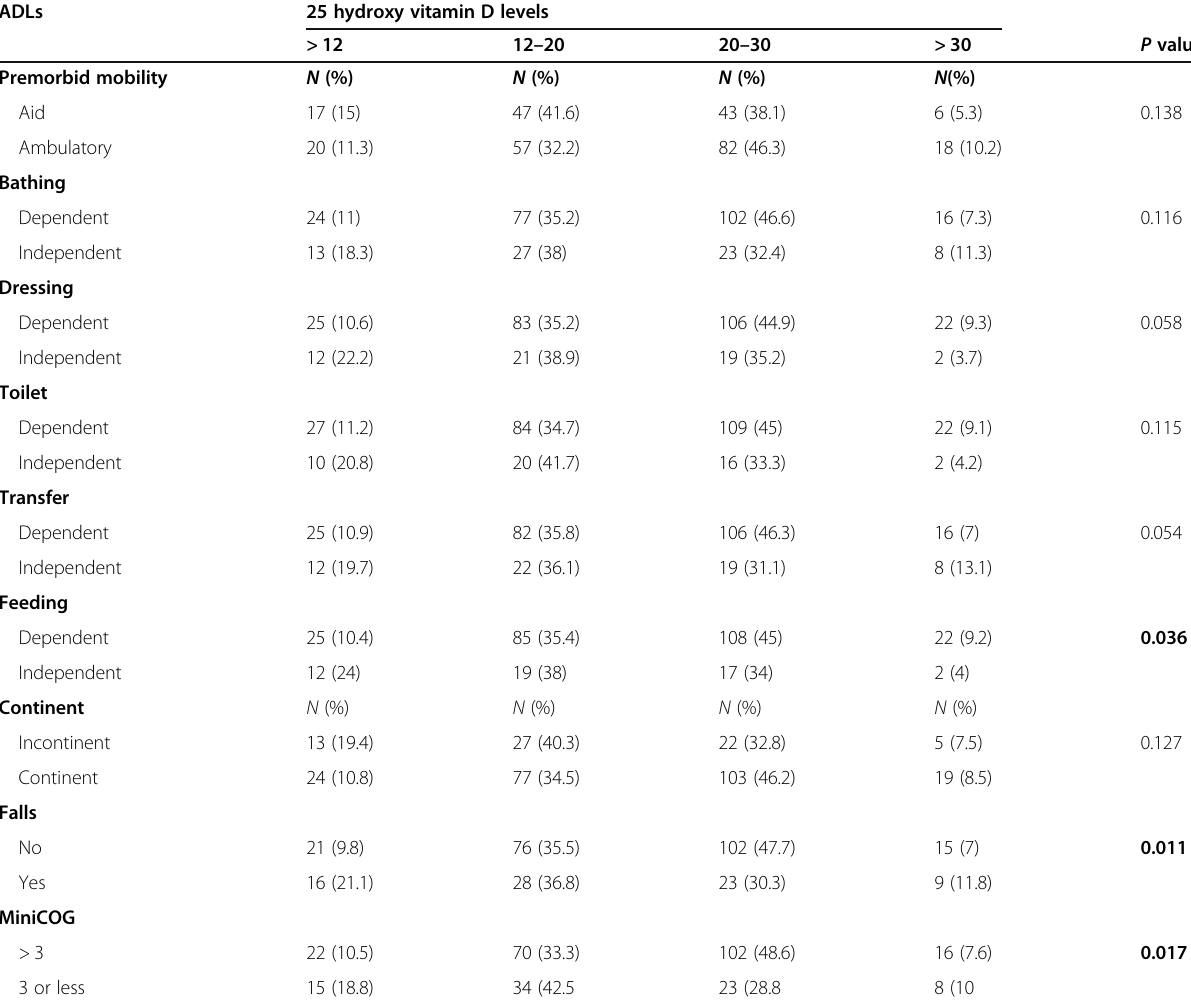
Table 4 Correlations between 25 hydroxy vitamin D levels and comprehensive geriatric assessment